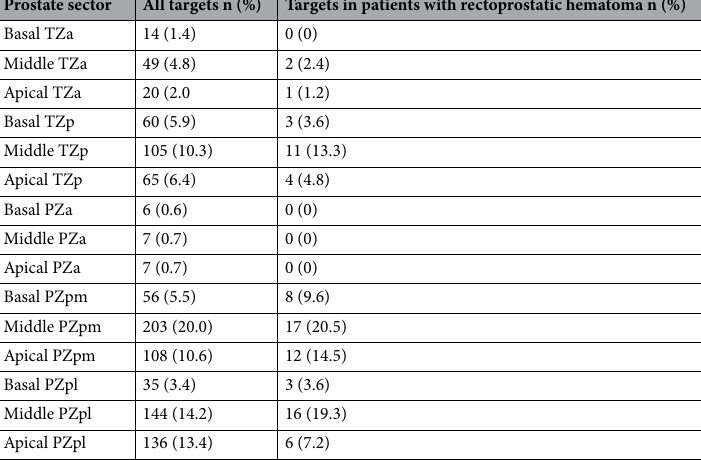
Lateral needle path included n